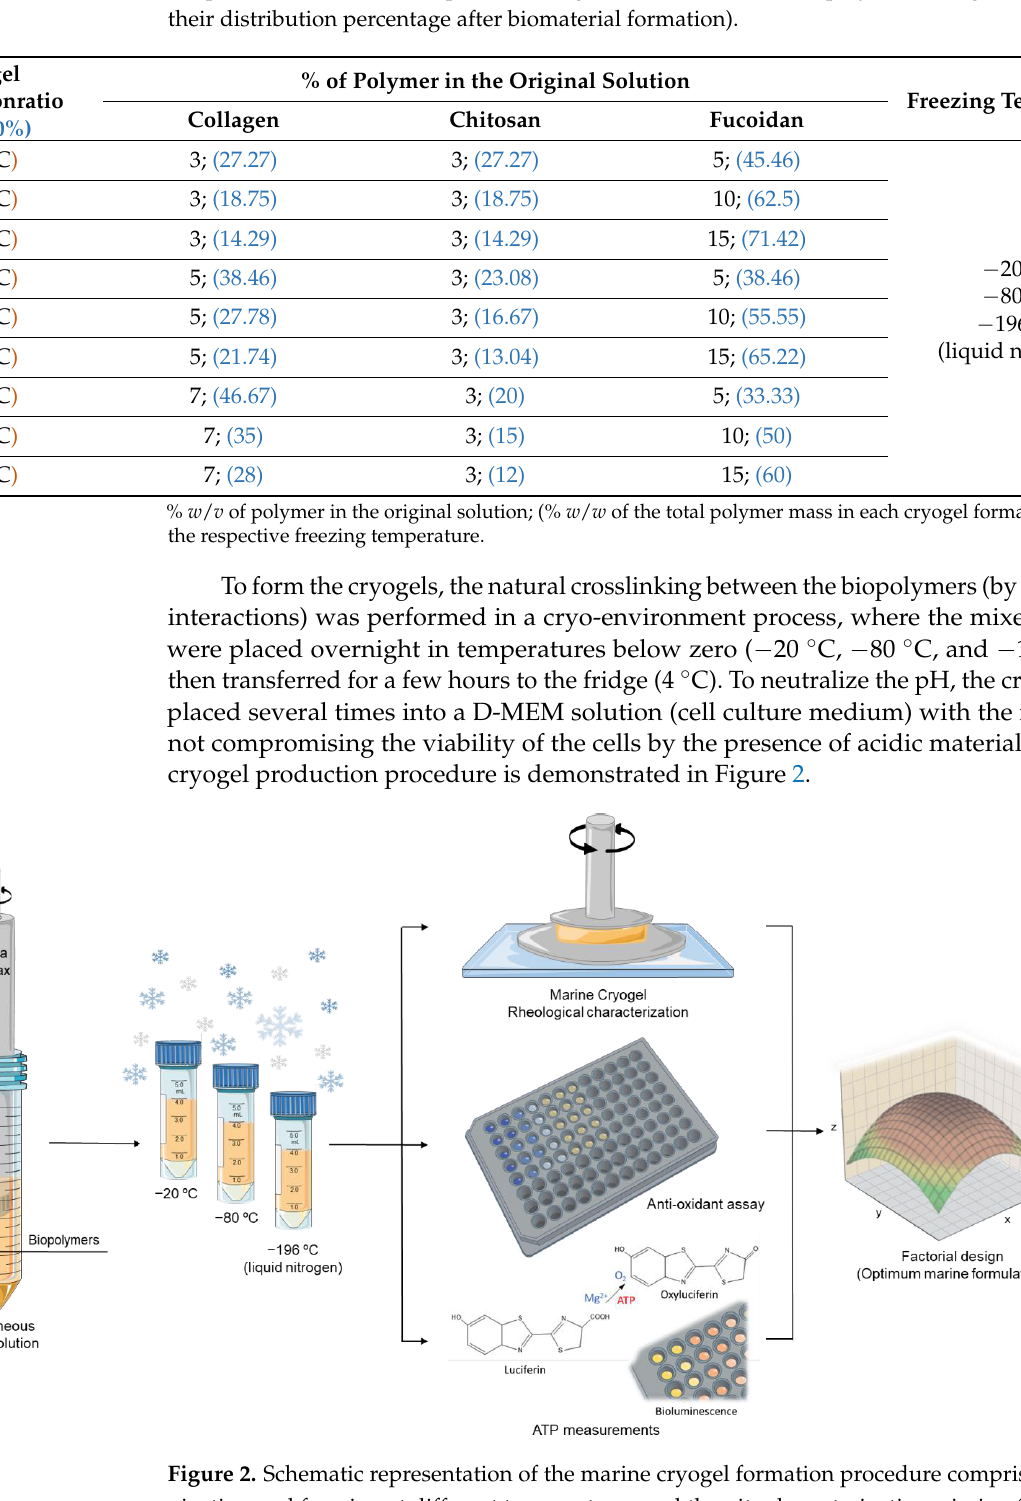
Table 1. Cryogel composition prepared by blending three marine origin biopolymers using different temperatures below zero to promote the gelation (ratio of each biopolymer in original solution and their distribution percentage after biomaterial formation).